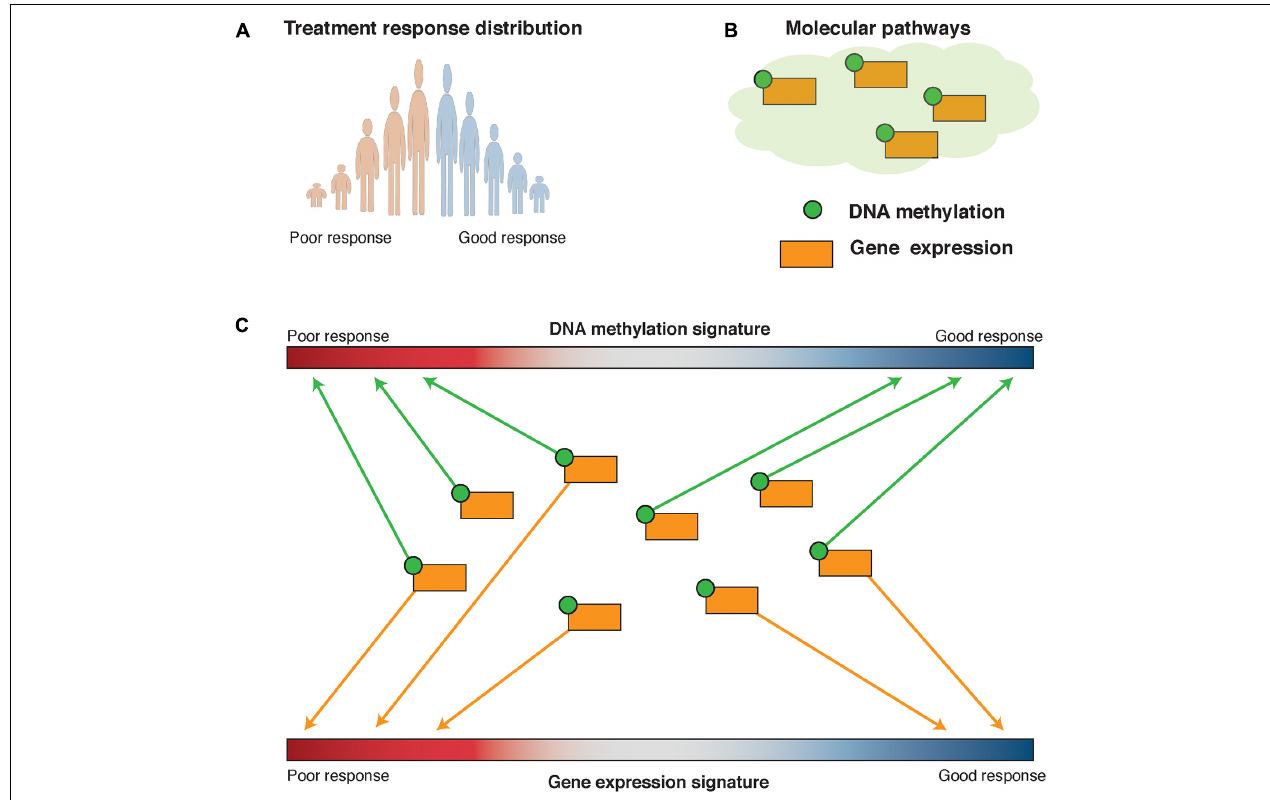
FIGURE 6 | Pathway-based modeling: pathCHEMO and pathER. (A) Therapeutic response distribution is defined based on time to therapeutic failure. Tails of this distribution are utilized in pathCHEMO and a full spectrum of therapeutic responses is utilized in pathER. (B) Molecular pathways are utilized as a knowledge base in pathway-based modeling. Genes in such pathways can be affected on multiple levels, such as differential expression (i.e., orange square) and DNA methylation (i.e., green satellite). (C) Molecular pathways are assessed for their integrated enrichment and association with therapeutic